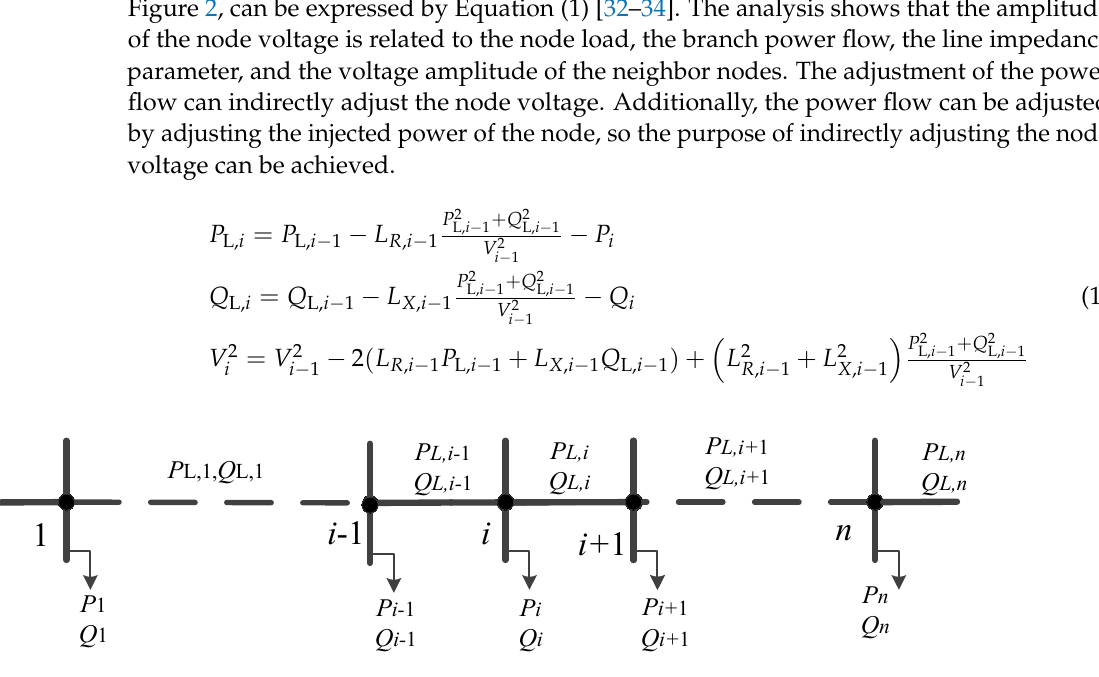
Figure 1. Node voltage regulation model of LVDN with a high proportion of distributed PV sources. The black arrow is the load of each node, while the dash blue lines with arrow are the communica- tion links.